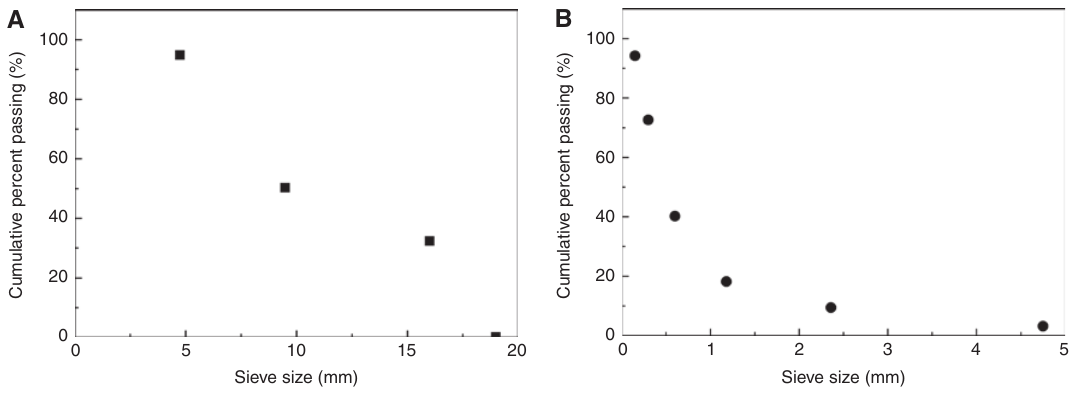
Figure 1: A) Sieve analysis of coarse aggregates; B) sieve analysis of fine